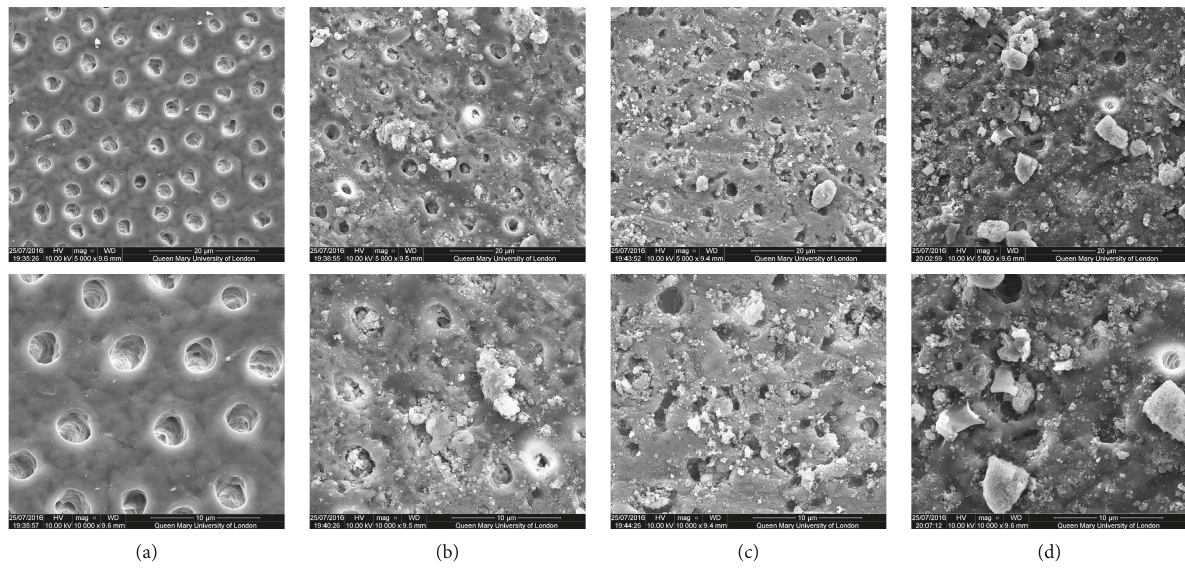
Figure 3: SEM images of the dentine surface morphology in disc 3 treated with a BioMinF glass-based toothpaste at 5000x (top) and 10000x (bottom) magnifications. (a) Control; (b) after brushing with a bioactive glass-based toothpaste; (c) after brushing with a bioactive glass- based toothpaste+artificial saliva immersion for 1 hour; (d) after brushing with a bioactive glass-based toothpaste+acid challenge with 6% citric